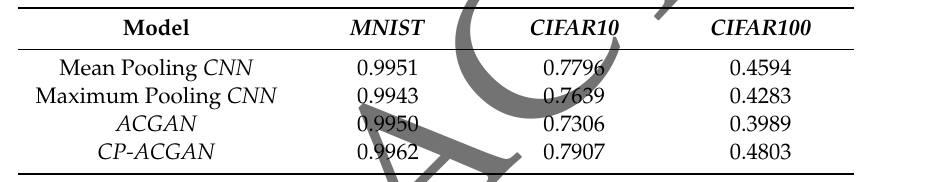
Table 1. Best prediction accuracy of different methods on MNIST, CIFAR10, and CIFAR100.